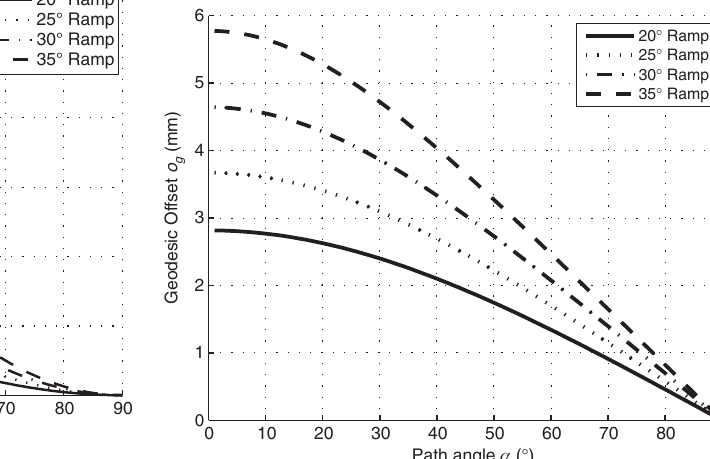
as a function of path angle for 1